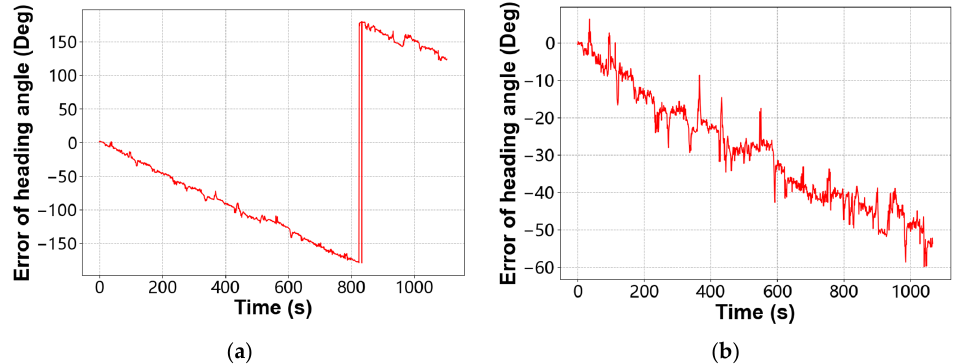
Figure 7. Heading angle error before correction. ( a ) Smartphone Huawei P30; ( b ) Smartphone Huawei P40.